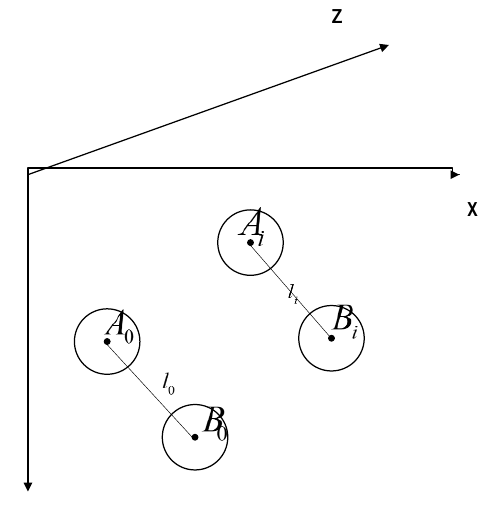
Figure 6. Strain diagram before and after structure deformation.